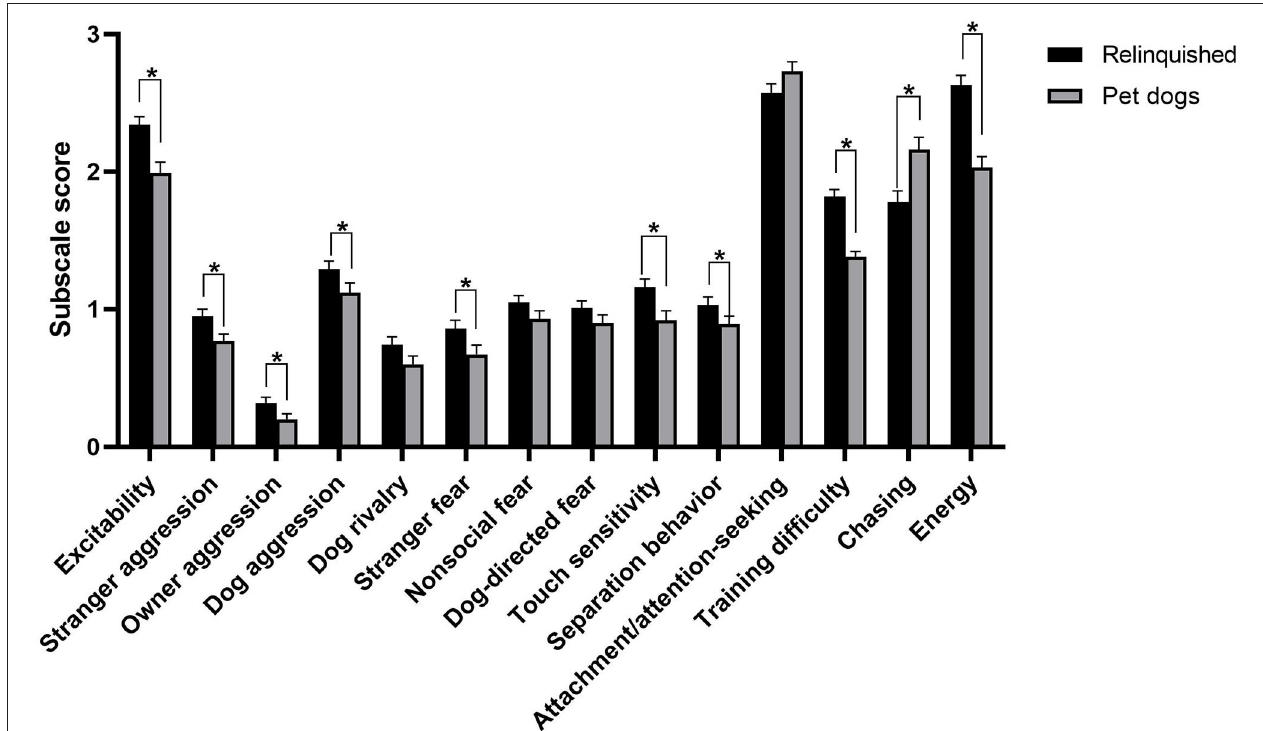
FIGURE 3 | C-BARQ subscale scores between relinquished and pet dogs. Data are shown as mean ± SEM. * indicates statistical significance ( p <